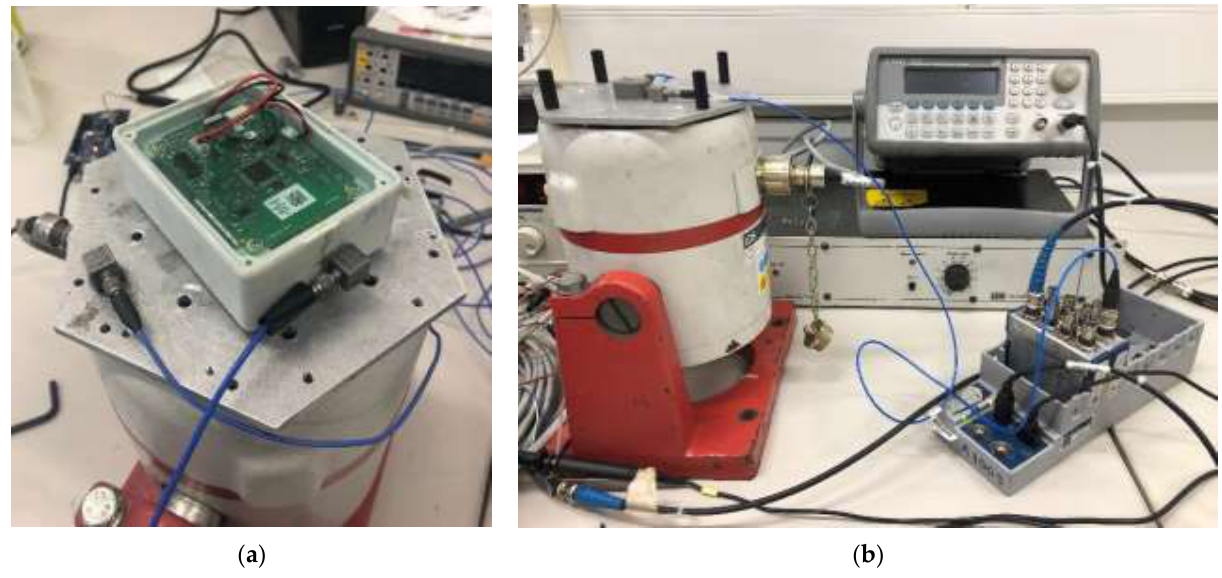
Figure 5. Shaker test: ( a ) WindNode and reference accelerometers mounted on the shaker and ( b ) overview of the instrumentation composing the test set-up.